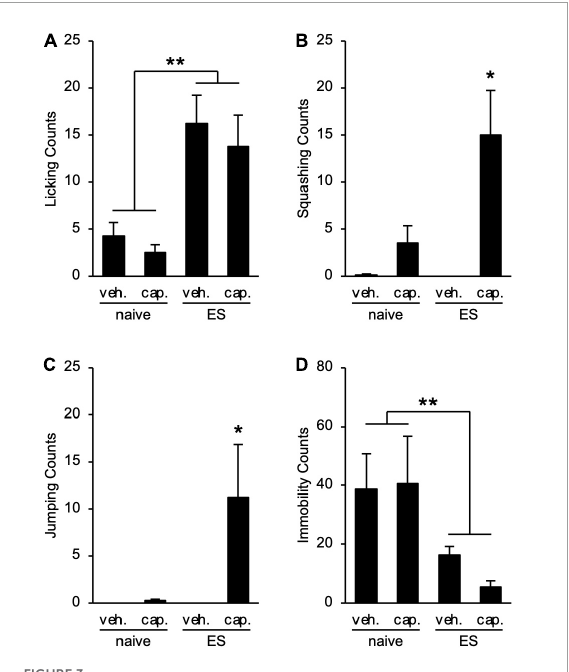
FIGURE3 Chronic vicarious social defeat stress induces abdominal hyperalgesia. (A–D) Visceral pain-related behavior counts in the capsaicin-induced hyperalgesia test. (A) Licking; (B)